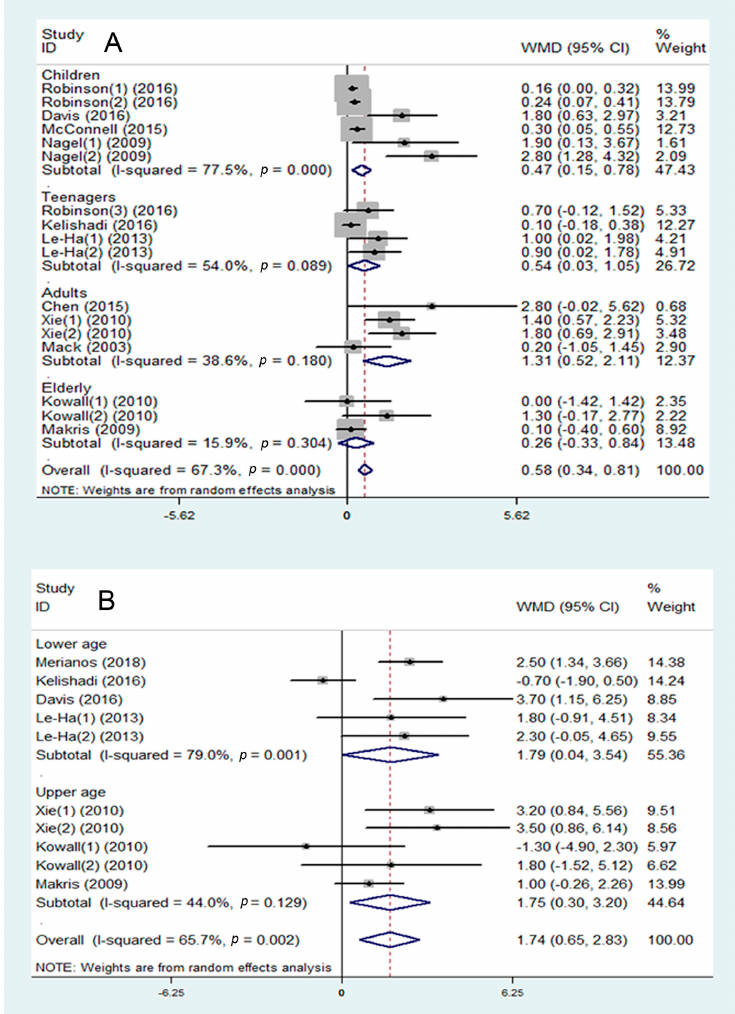
Figure 4. Meta-analysis of secondhand smoke (SHS) and risk of abdominal obesity: ( A ) association between SHS and body mass index (BMI); ( B ) association between SHS and waist circumference (WC). WMD — weighted mean difference; SMD — standard mean difference.